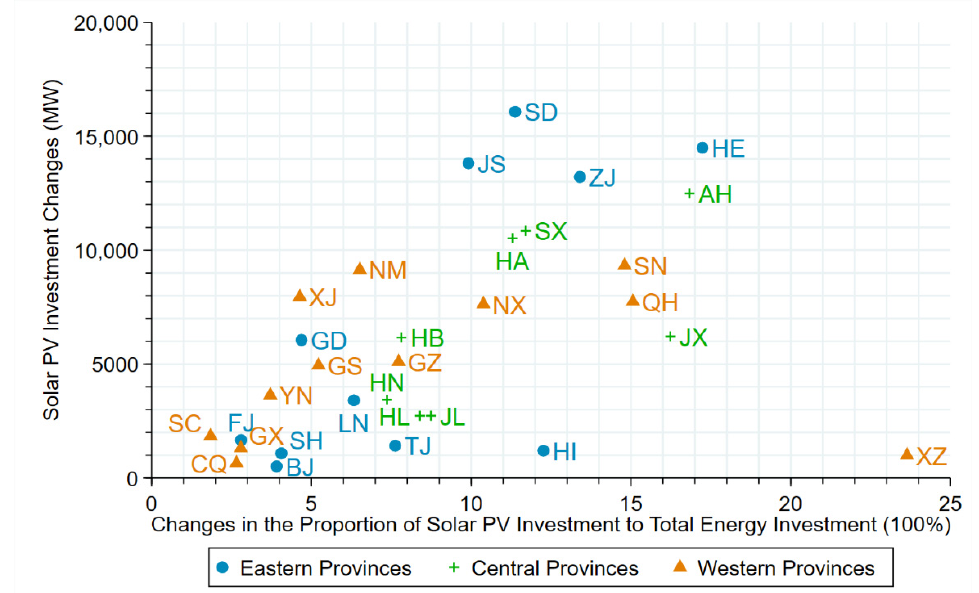
Figure 2. Growth in solar PV investment and growth in the proportion of solar PV investment to total energy investment, total energy investment, 2013–2019.